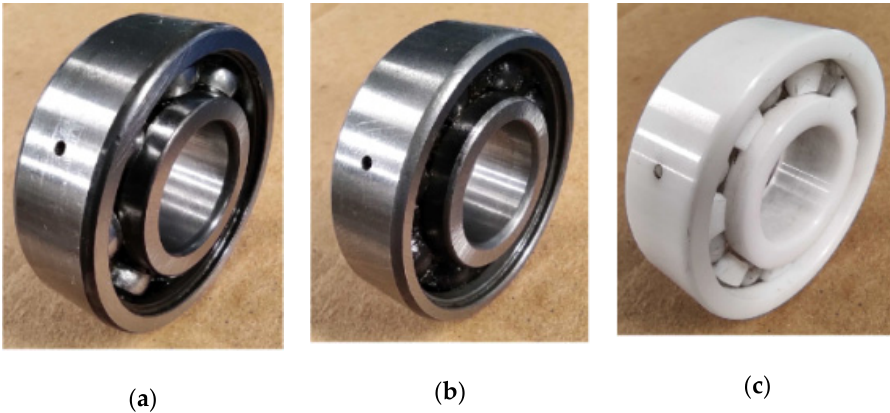
Figure 5. Set of damaged bearing used to be experimentally tested in the IM of an electromechanical system: ( a ) metallic damaged bearing, ( b ) hybrid damaged bearing and ( c ) full ceramic damaged bearing.